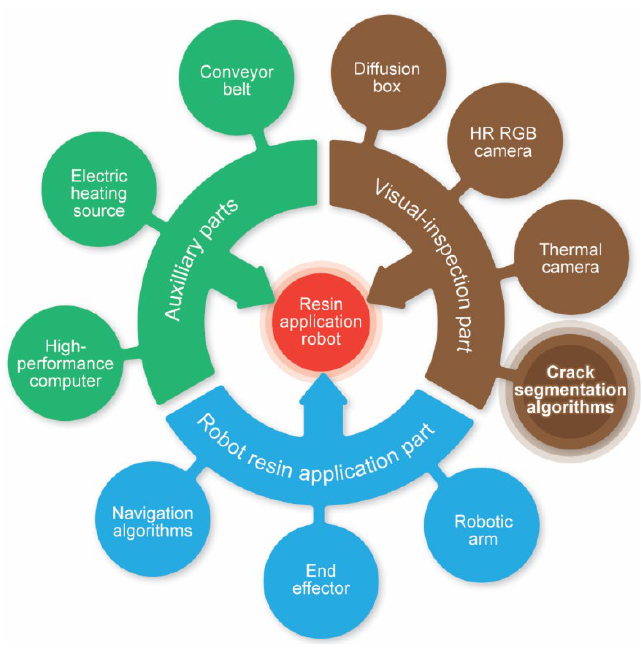
Figure 12. Conceptual design of a robotic resin application system for marble slabs.